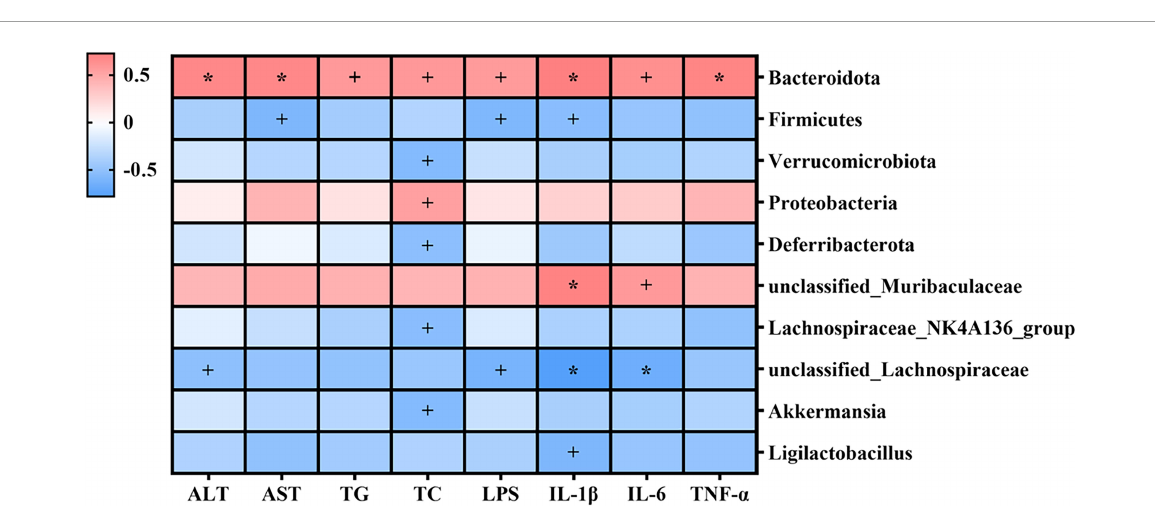
FIGURE8 Heatmap of Spearman’s correlations between gut microbiota and indexes related to alcohol-induced liver injury (including serum parameters and hepatic inflammatory cytokines). Blue denotes negative correlation, and red represents positive correlation. + p < 0.05; * p < 0.01.